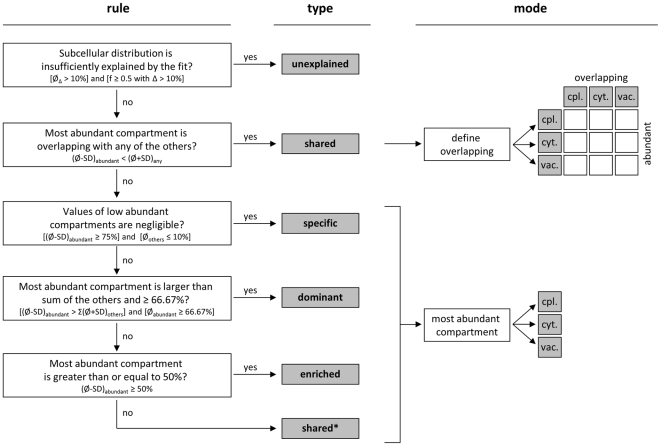
Manually constructed classification tree for the partitioning of analytes into compartments and intermediate units based on their estimated subcellular distribution as well as compartmental abundance and variability.The classification tree was used to assign an analyte into a group defining its subcellular distribution type (type) and an associated mode (mode) which represents one of the resolved compartments or the overlap between them. Assignments are based on the mean and standard deviations of the subcellular distribution, estimated using the best fit algorithm (BFA), for each analyte based on the three independent gradient data. Analytes with insufficiently explained subcellular distributions according to the selected compartment-specific markers are accounted as unexplained and are not further considered in this tree. Analytes revealing sufficiently explained fits are accounted as ‘shared’ if the minimum of the percentage value (min  =  mean - SD) in the most abundant compartment is overlapping with the maximum percentage value (max  =  mean + SD) of any other considered compartment. The corresponding mode is defined by the overlapping compartments regarding the most abundant compartment. Analytes are considered ‘specific’ with the mode according to the estimated most abundant compartment, if the minimum of the most abundant compartment is ≥75% and the values of all other (low abundant) compartments are negligible, i.e. ≤10%. If the minimum in the most abundant compartment is larger than the sum of the maxima among the other compartment and ≥66.67% (2/3 compartments), analytes are accounted as ‘dominantly’ distributed in the respective compartment. Analytes are accounted as ‘enriched’ in a compartment, if the value of the most abundant fraction is ≥50% than the sum of the other compartment. If none of this decisions result in an assignment the analyte is considered as being shared but with enrichment in a particular compartment (‘shared*’).